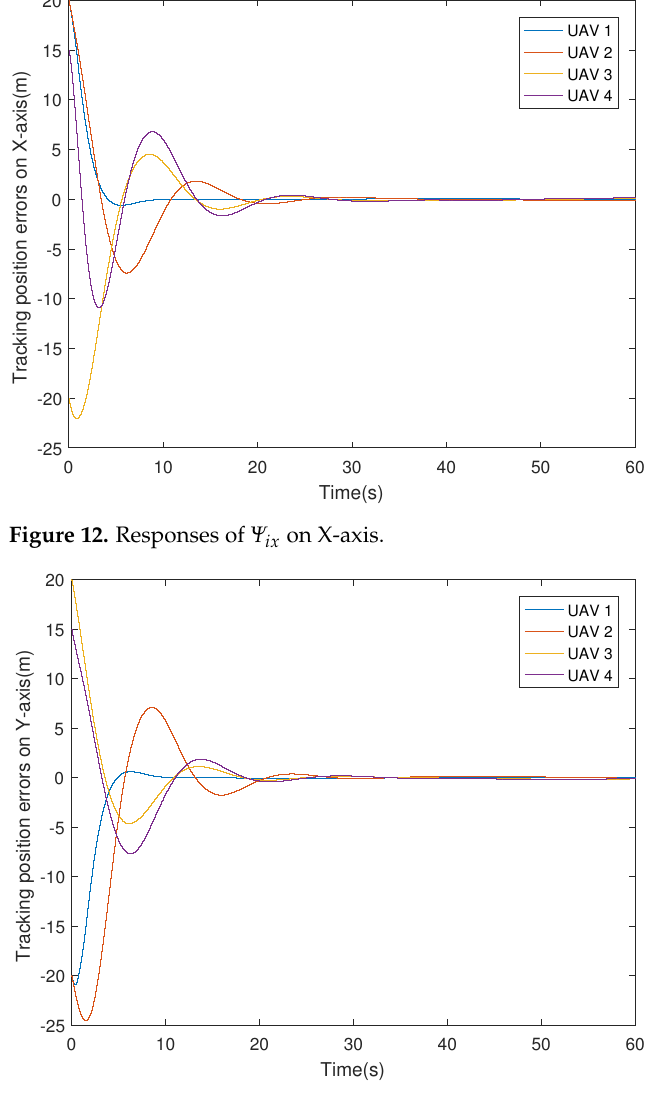
Figure 13. Responses of Ψ ix on Y-axis. Table 1. The average number of released data packets of four UAVs on X- and